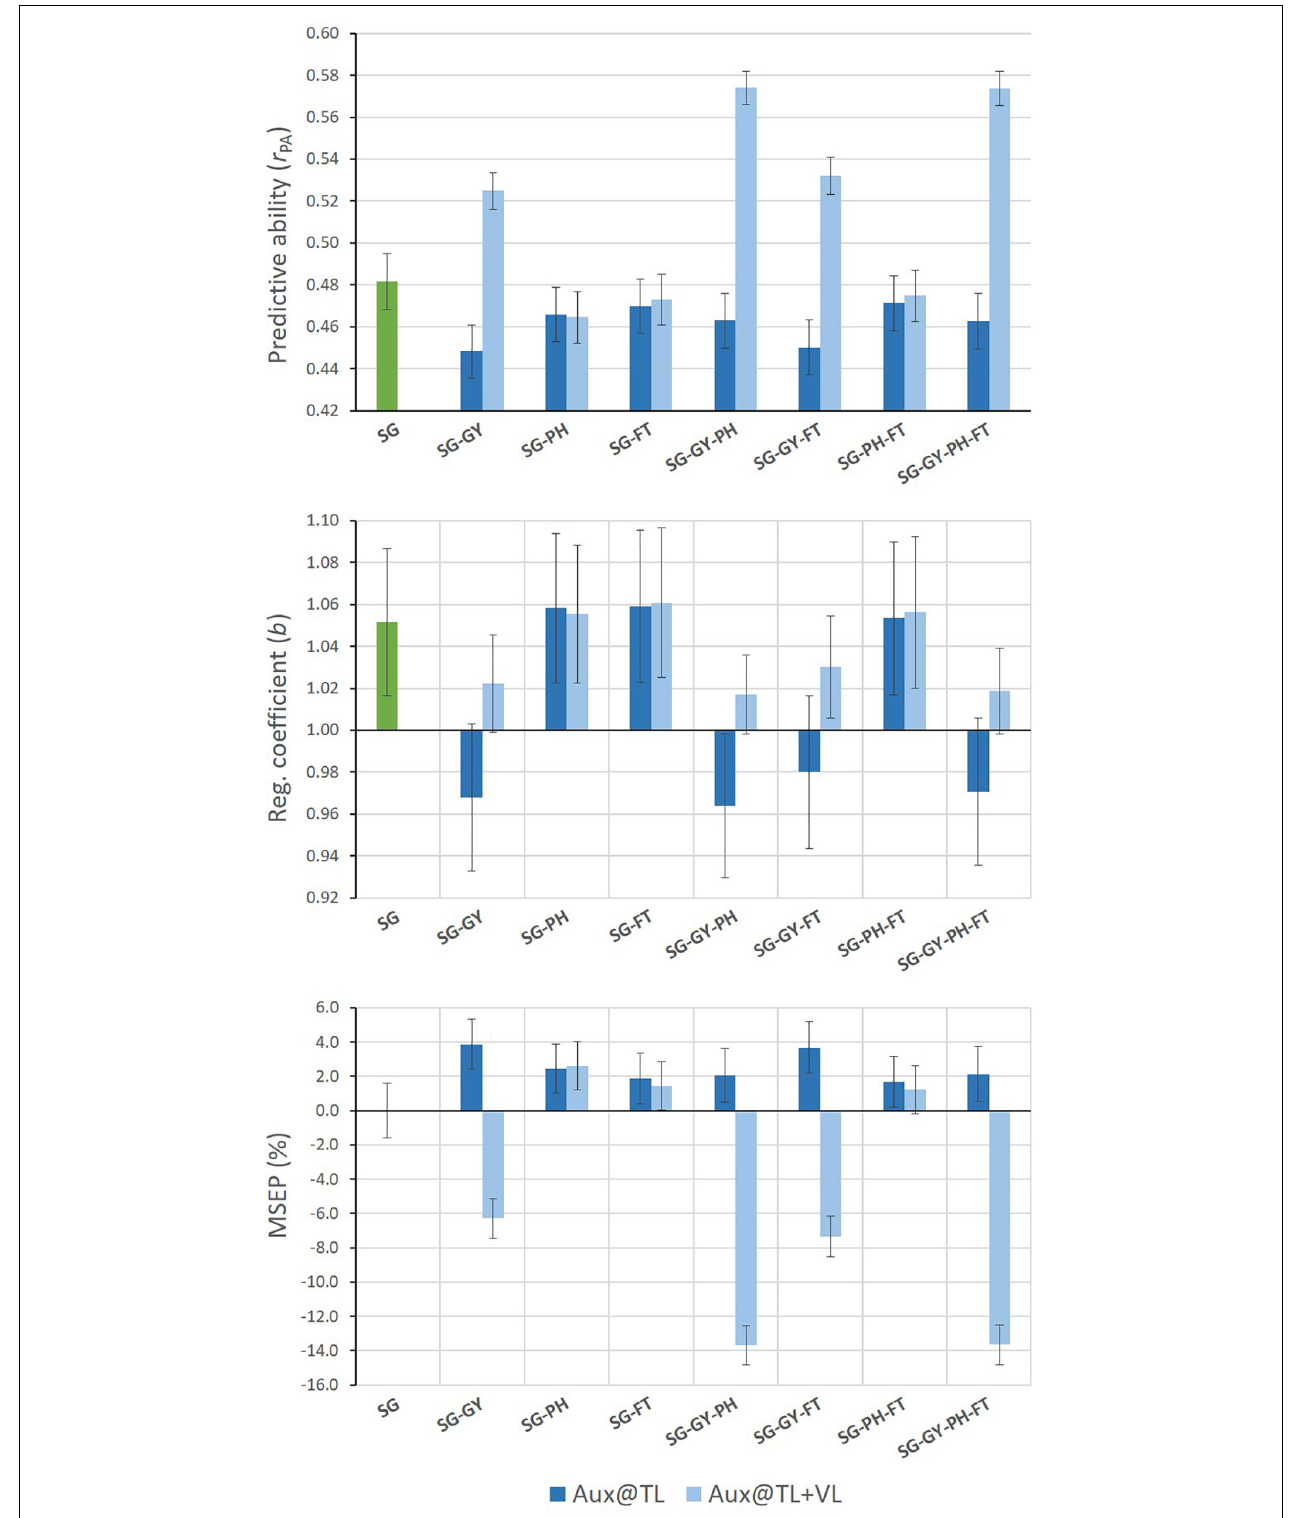
FIGURE 3 | Mean values (and SD of 20 replicates) for predictive ability, regression coefficient, and relative MSEP for SG predictions from single- and multi-trait G-BLUP models using different combinations of grain yield (GY), stay-green (SG), plant height (PH), and flowering time (FT) data only in the training lines set (Aux@TL), and in both the training and validation lines sets (Aux@TL + VL).